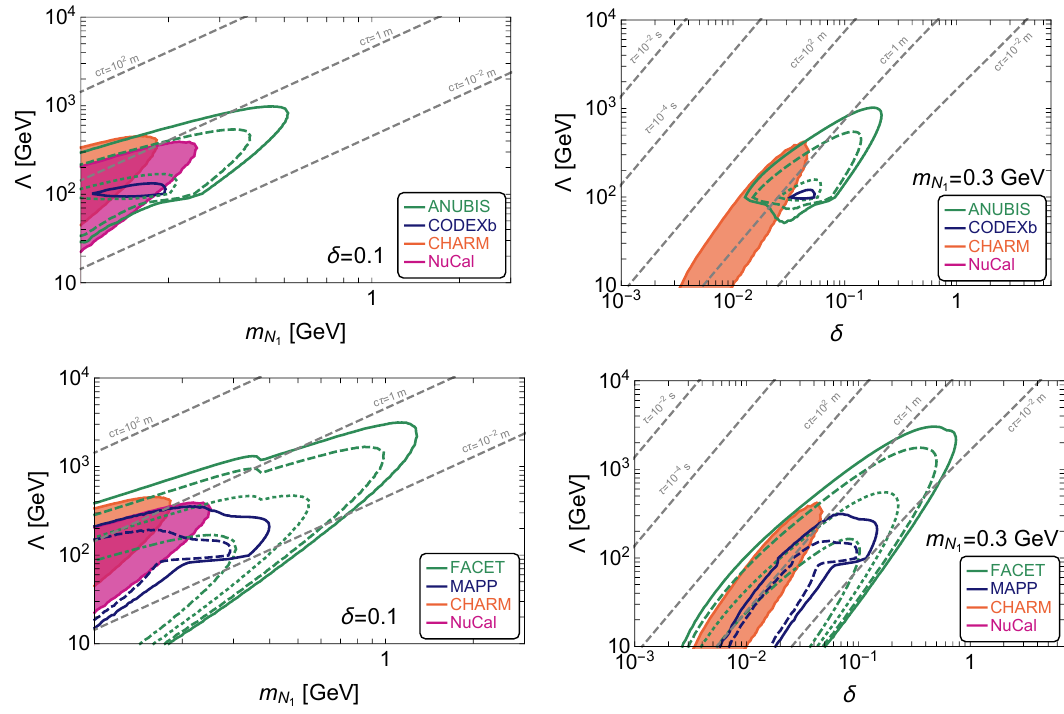
Figure 3 . Sensitivity reach of the experiments ANUBIS, CODEX-b, CHARM and NuCal. Solid, dashed, dotted and dot-dashed lines correspond to N N signal = 1000 . The colored regions and the dashed lines are as in figure 1. We fix α = π/ 2